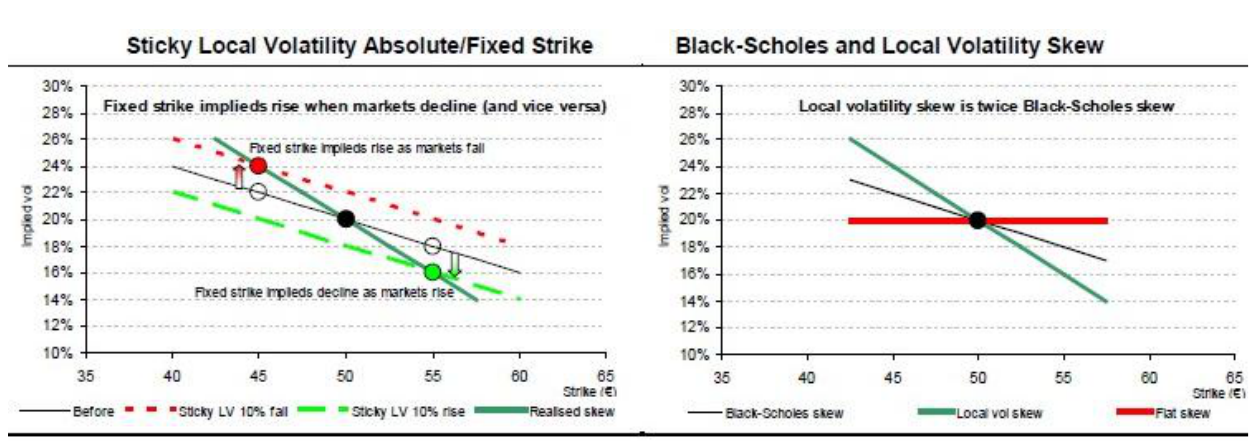
Figure 5. Dynamics of a local volatility surface (Taken from